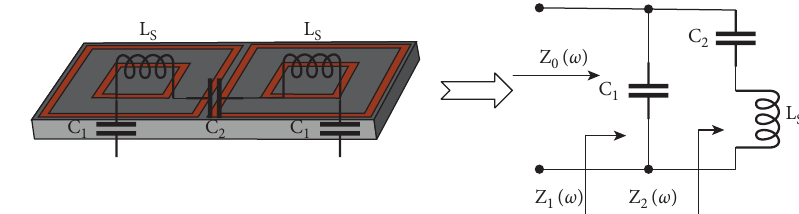
Figure 2: Equivalent circuit model of the AMC.